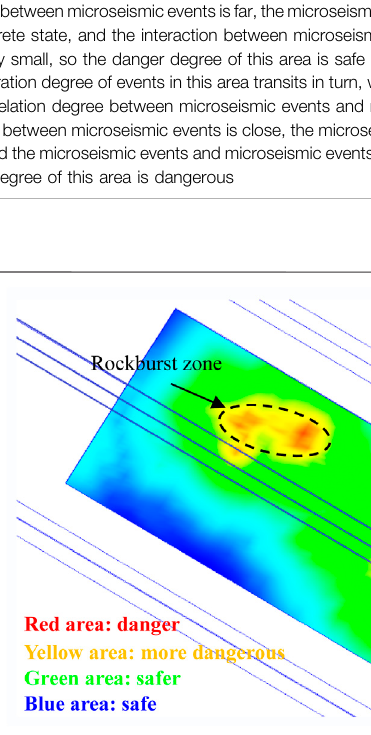
FIGURE 5 | Rockburst hazard zoning by the contour of microseismic energy